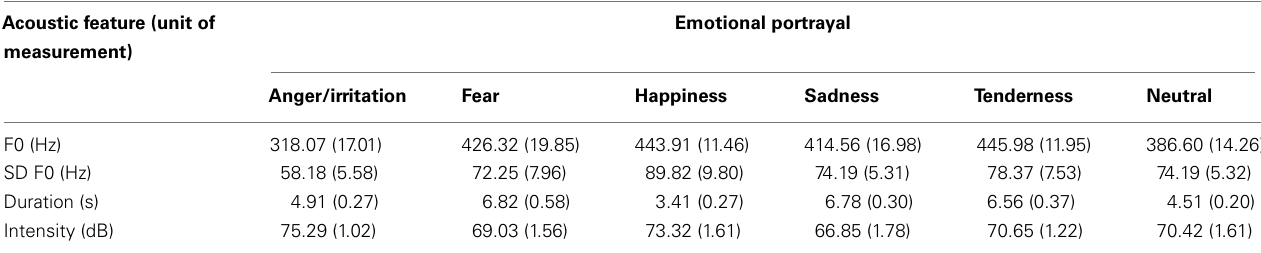
Table 2 | Means associated with the acoustic features of the musical stimuli (standard errors are shown in